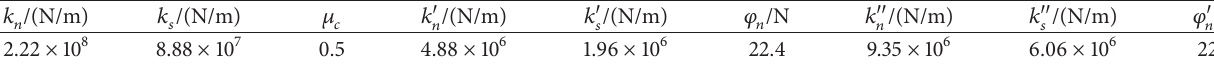
Table 4: Micromechanical modeling parameters at different contacts.